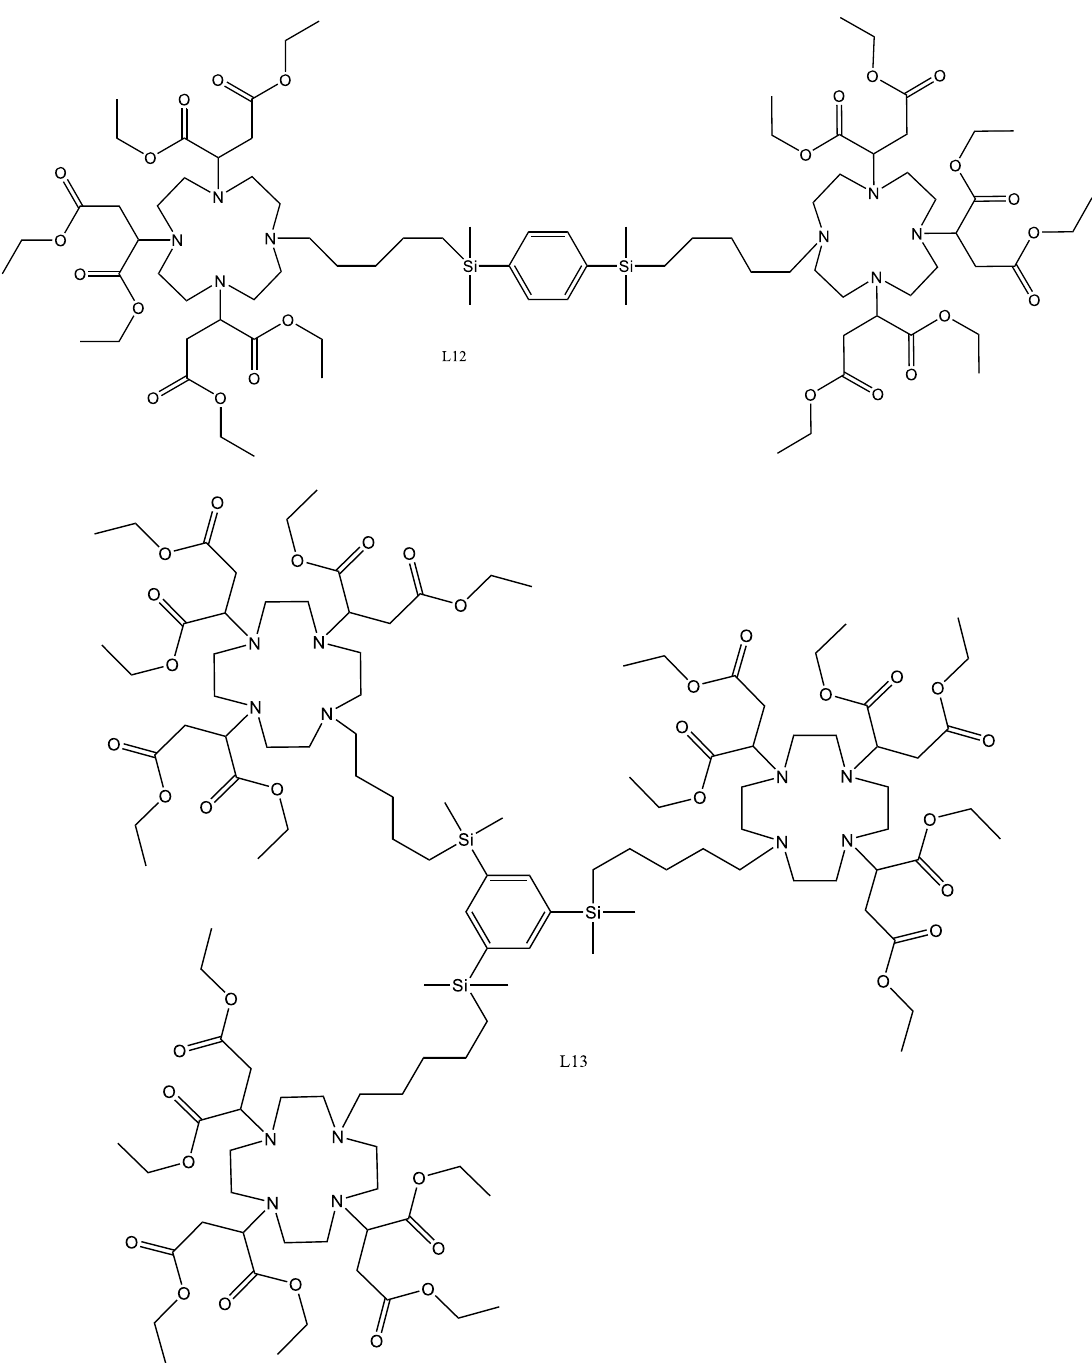
Figure 6. Structures of the bis- (L12) and tris- (L13) substituted scaffolds with cyclen ligands.